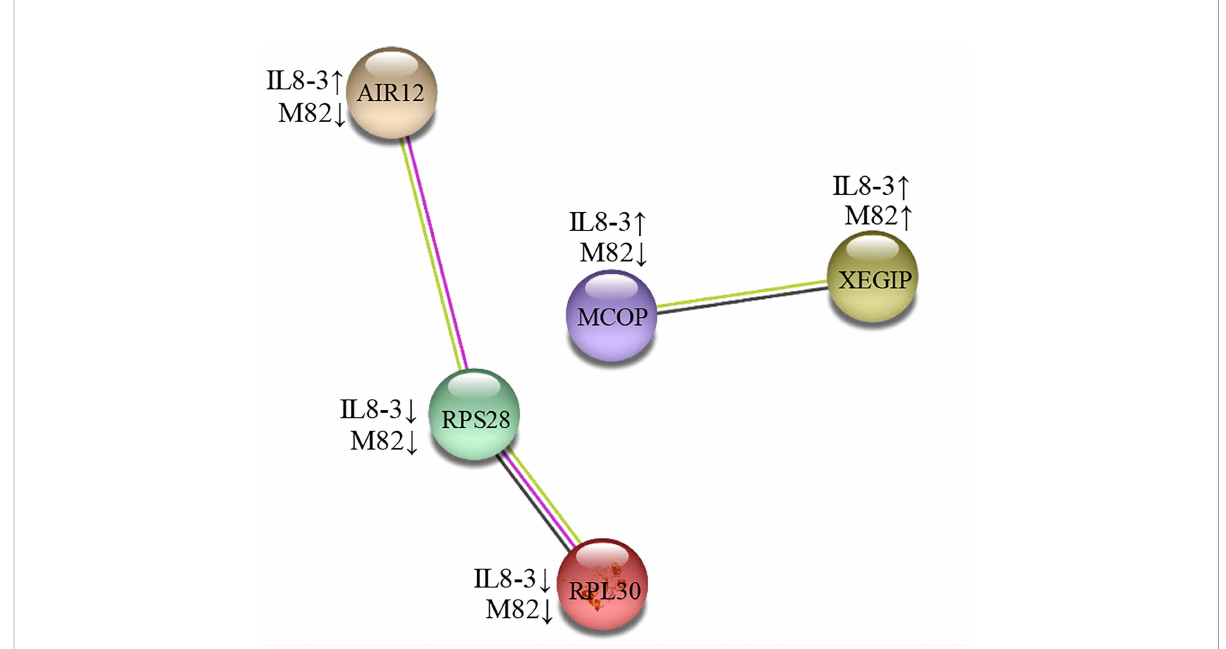
FIGURE 4 A protein interaction network of differentially abundant proteins (DAPs) under salt stress both of IL8-3 and M82. The network was built using a STRING software (https://string-db.org/) with medium con fi dence. The nodes represent the DAP, and the line color indicates the type of interaction evidence. The up and down arrow behind the cultivars represent increased and decreased in protein abundance under salt stress, respectively. AIR12, auxin-induced in root cultures protein 12; RPS28, 40S ribosomal protein S28; RPL30, 60S ribosomal protein L30, MCOP, multicopper oxidase-like protein precursor; XEGIP, xyloglucan-speci fi c fungal endoglucanase inhibitor protein